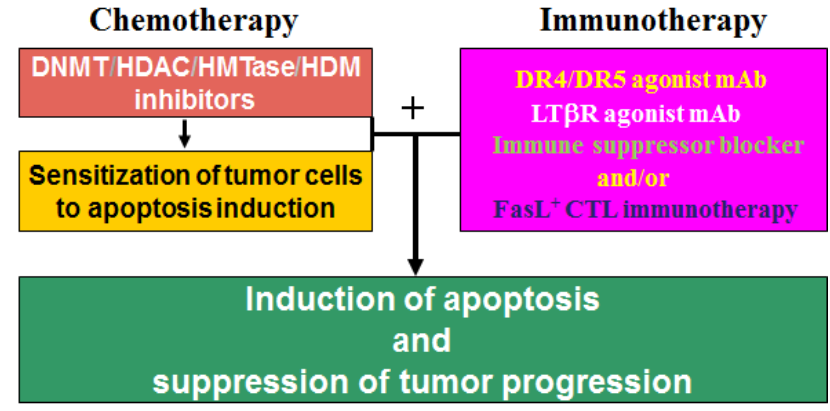
Figure 3. A ―one-two punch‖ strategy of combined chemotherapy and immunotherapy to suppress metastatic human CRC. The apoptotic-resistant CRC cells are first targeted with apoptosis-sensitizing epigenetic drug(s) (e.g., decitabine and vorinostat) to sensitize the tumor cells to apoptosis. Once ―sensitized‖, patients are then treated with immune effector molecules or FasL + tumor-specific CTLs that promote apoptosis to effectively destruct the